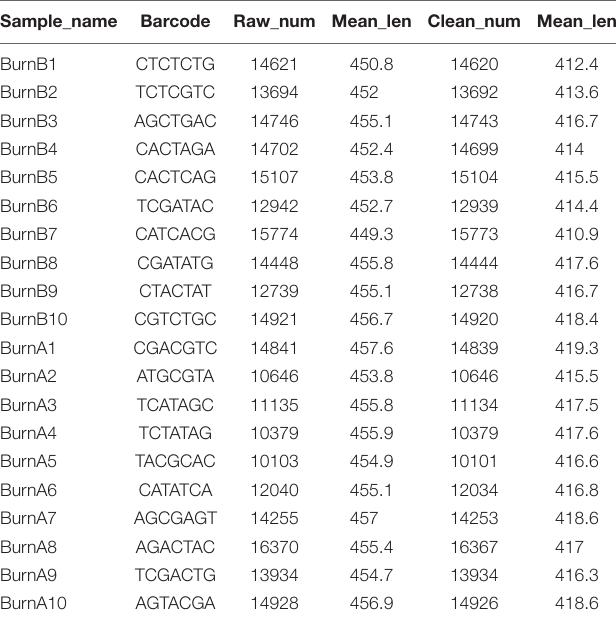
TABLE 1 | 16S rRNA gene sequencing statistics for the 20 pre- and post-burn